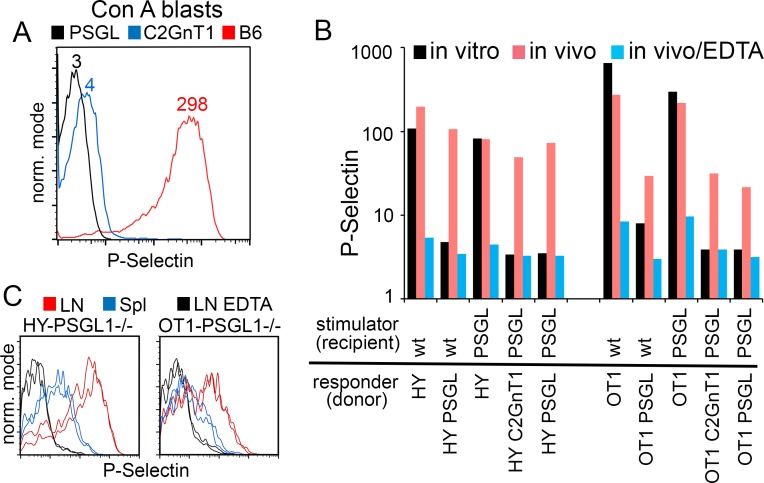
Detection of a PSGL1-independent P-selectin ligand on in-vivo activated T cells.(A) Formation of PSGL1-PSelL requires C2GnT1: Spleen cells from B6, PSGL-1null, or C2GnT1null mice were activated in vitro with Concanavalin A for two days, sub-cultured with IL2 supplemented media for two additional days, and then stained with PSel-hIgG chimera. P-selectin geometric mean fluorescence values shown. Figure representative of more than nine independent analyses. (B) A PSGL1-independent P-selectin ligand is detected on CD8 T cells activated in vivo. Geometric mean P-selectin staining of day-3 activated HY male-antigen specific, or OT1 ovalbumin specific, T cell receptor transgenic CD8+ T cells responding to antigen in vitro or in vivo. Responding T cell receptor transgenic cells on wild type (wt), PSGL-1null, or C2GnT1null genetic backgrounds were either stimulated in vitro with splenic dendritic cells (male or Ova-pulsed) from B6 (wt) or PSGL-1null mice, or adoptively transferred into wt or PSGL-1null male recipients. EDTA was included during P-selectin staining in parallel samples of in-vivo generated cells to confirm divalent cation (Ca++) dependent selectin binding. Flow analysis was gated for viable propidium iodidenegative (PIneg), CD8+, responding (CFSE-diluted) donor cells. The data shown are single sample staining values representing biological replicates for the two T cell receptor transgenic models examined. Fig 1B is representative of more than seven independent analyses. (C) PSL2 is preferentially displayed by CD8+ activated T cells responding in peripheral lymph node. P-selectin staining of CFSE-labeled HY-PSGLnull T cells responding in two PSGL1null male recipients (left panel) or CFSE-labeled OT1-PSGLnull T cells responding to ovalbumin antigen in two PSGL1null recipients (right panel). Donor cells were recovered from peripheral lymph nodes or spleen three days after adoptive transfer. Staining of duplicate recipient mice are shown for each donor. Control P-selectin staining in the presence of EDTA shown for respective donor/recipient combinations. Ex-vivo cells were subjected to gating for viable PIneg, CD8+, responding (CFSE-diluted) donor cells. Geometric mean P-selectin values for HY-PSGLnull (left panel) are LN EDTA 4/4, spleen 14/15, lymph node 82/111; for OT1-PSGLnull (right panel) LN EDTA 5/5, spleen 8/10, lymph node 24/27. Fig 1C is representative of three independent analyses.